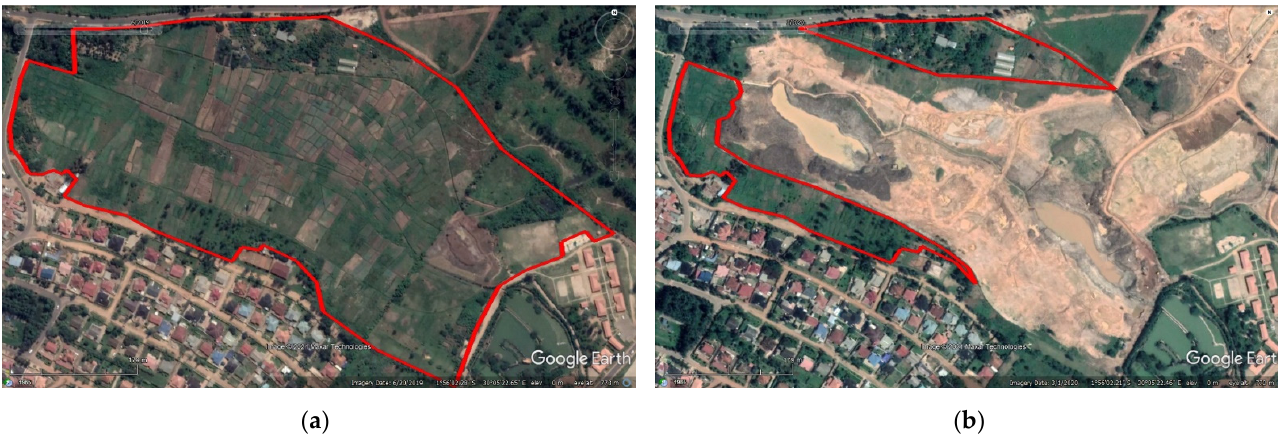
Figure 6. Area occupied by urban farming (limited by the red outline) in the Kinyinya sector in ( a ) June 2019; ( b ) in March 2020 during the construction of the golf course, map data: Google Earth ©2021/Maxar Technologies.